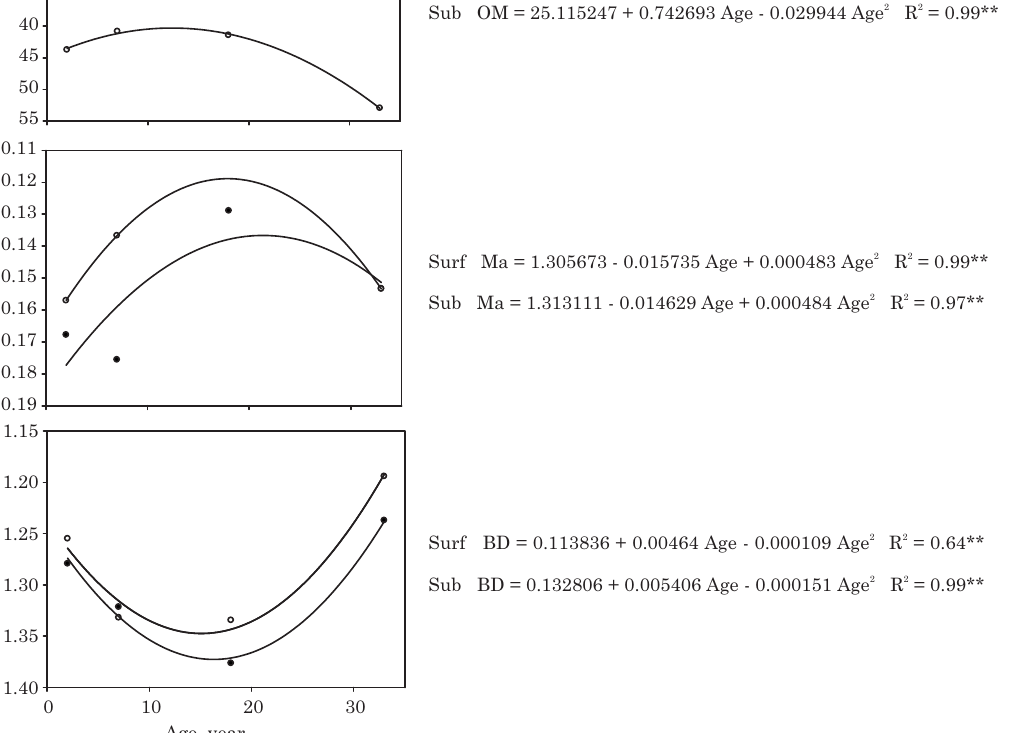
Table 3. Mean values of organic matter (OM), total porosity (TP), macroporosity (Ma) and bulk density (BD) for different sampling locations and depths in a Red-Yellow Latosol Depth